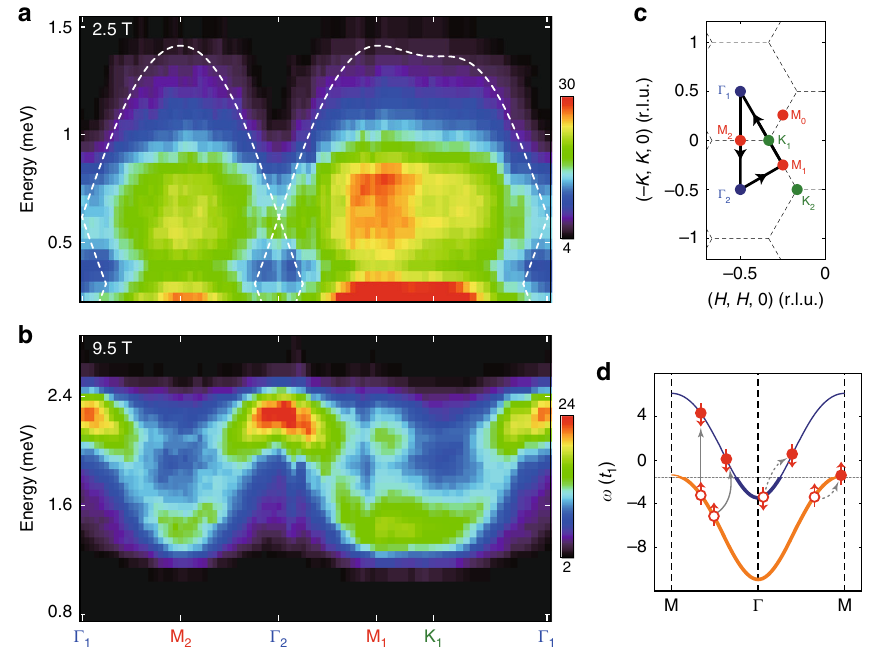
Fig. 2 Intensity of the spin excitation spectrum along the high-symmetry directions at 2.5 and 9.5 T at 70 mK. a Contour plot of the energy-dependent intensity at 2.5 T along the high-symmetry directions illustrated by the black lines in c . The white dashed lines indicate the calculated boundaries of the continuum based on the spinon Fermi surface model described in Methods. b Contour plot of the energy-dependent intensity in the nearly polarized state at 9.5 T. The color bar indicates scattering intensity in arbitrary unit in linear scale. c Sketch of reciprocal space. The dashed lines indicate the Brillouin zone boundaries. d The split spinon band structure along the high-symmetry points (vertical dashed lines) in momentum space. t 1 is the nearest-neighbor spinon hopping. The blue and orange bands are of spin-down and spin-up spinons, respectively. The horizontal dotted line indicates the Fermi level. The solid arrows indicate the spin- fl ipped inter-band particle-hole excitations while the dotted arrows indicate spin-un fl ipped intra-band particle-hole excitations